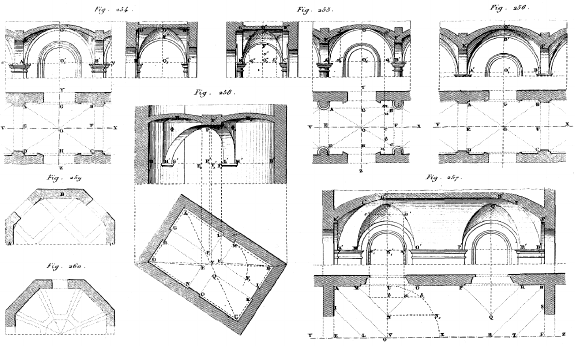
Figure 3 . Giovanni Curioni, Lavori generali di architettura civile (1865), Plate XXV. Masonry structure of compound vaults.